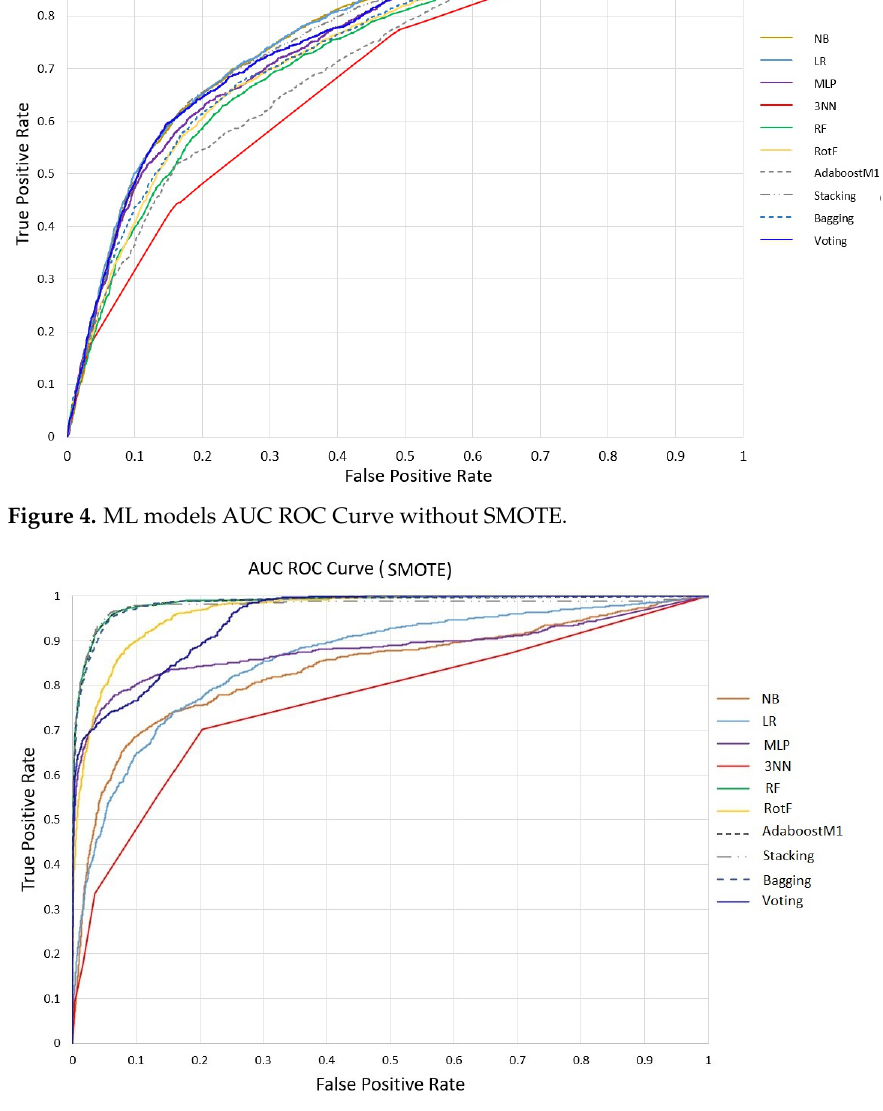
Figure 5. ML models AUC ROC Curve after